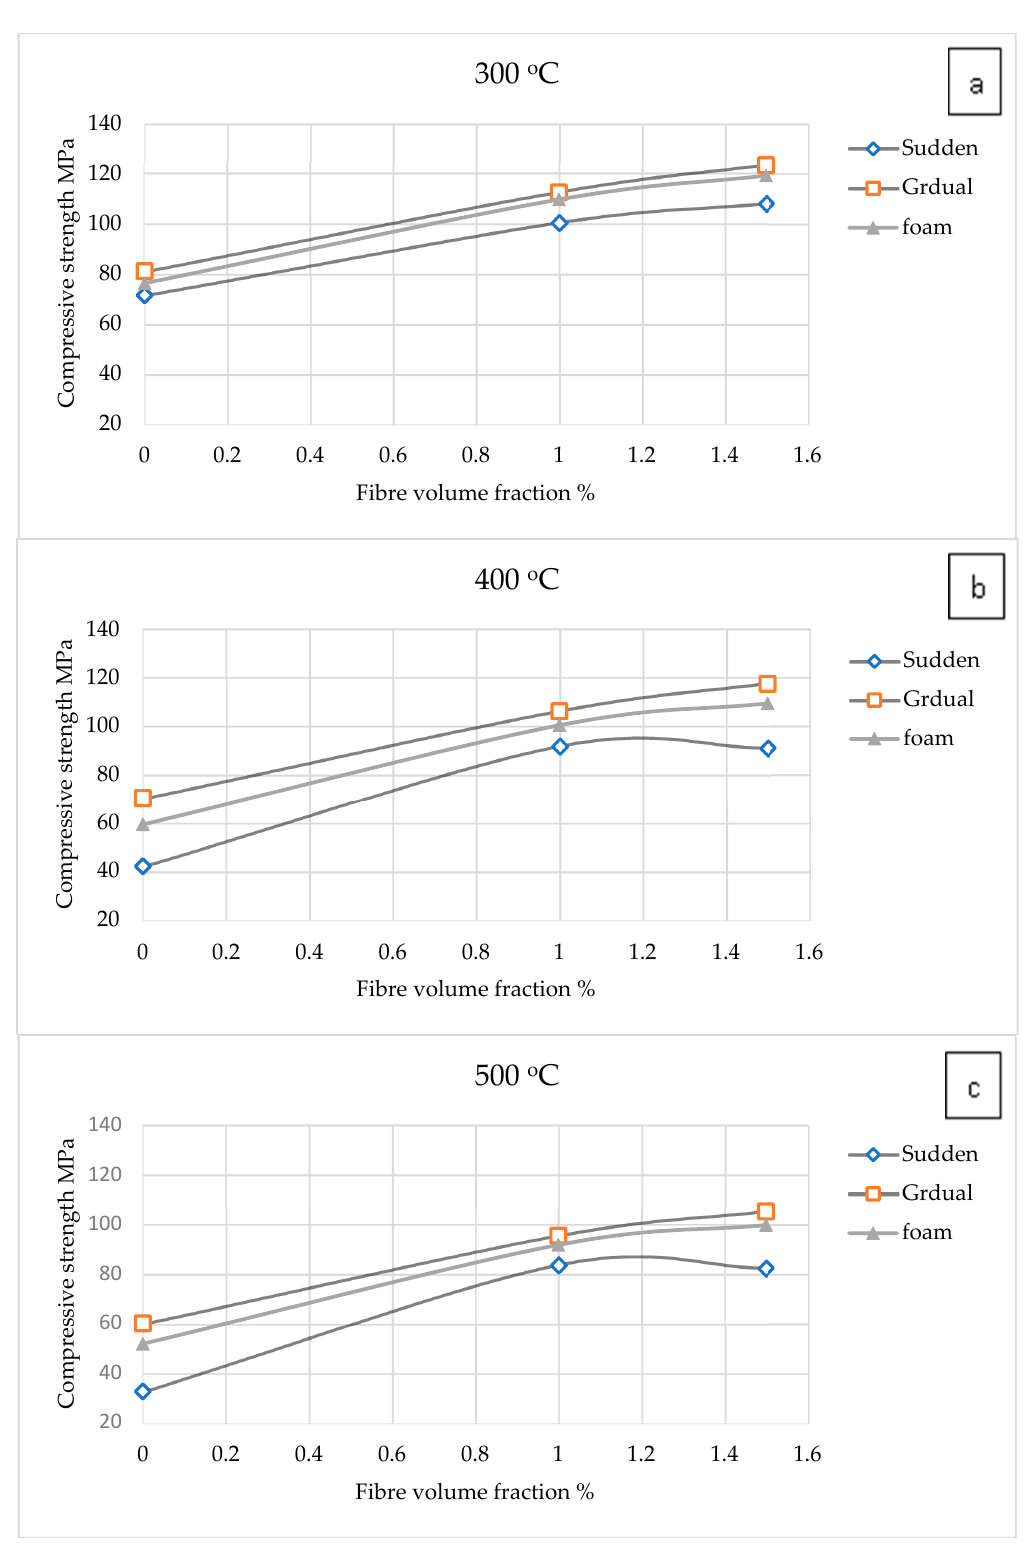
Figure 5. Compressive strength for various (RPC) specimens and cooling methods: ( a ) At burning temperature 300 °C; ( b ) At burning temperature 400 °C; and ( c ) At burning temperature 500 °C.